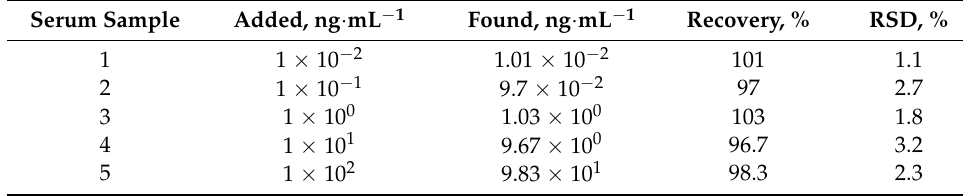
Table 1. Recovery experiments of the proposed PEC